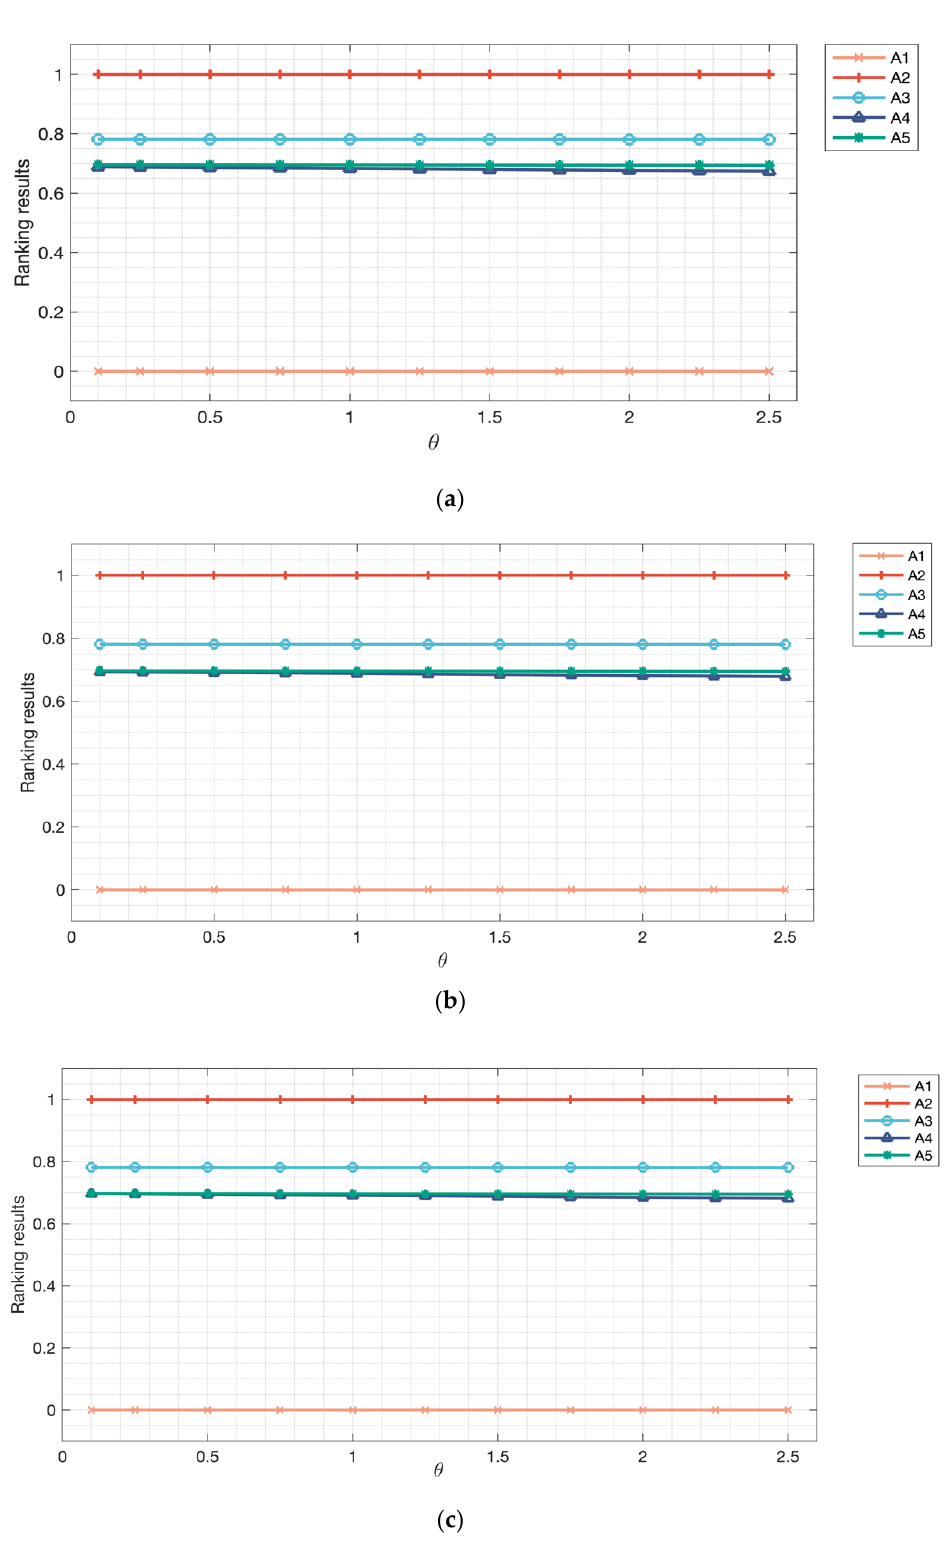
Figure 8. The effect of single stakeholder θ value fluctuations on results. ( a ) The effect of fluctuations in the government ’s θ value on the results; ( b ) the effect of fluctuations in the power plant ’s θ value on the results; ( c ) the effect of fluctuations in the investor ’s θ value on the results.